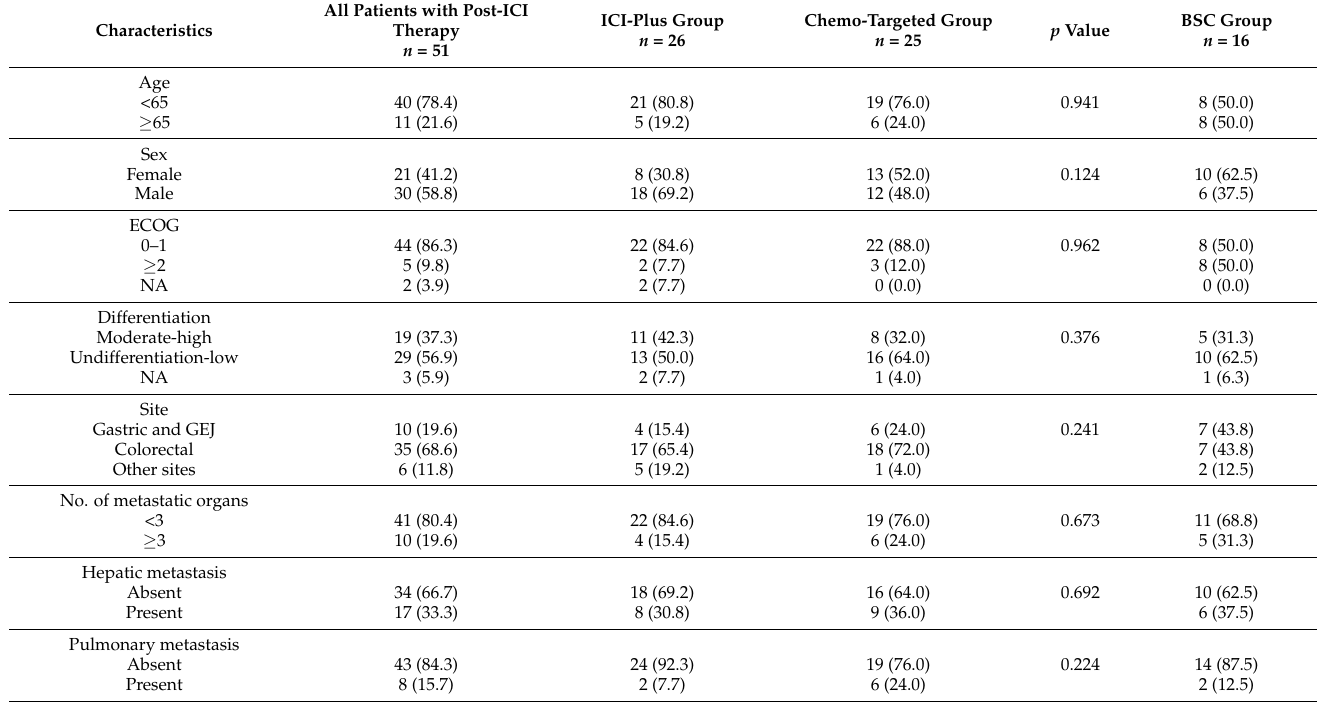
Table 1. Baseline characteristics of